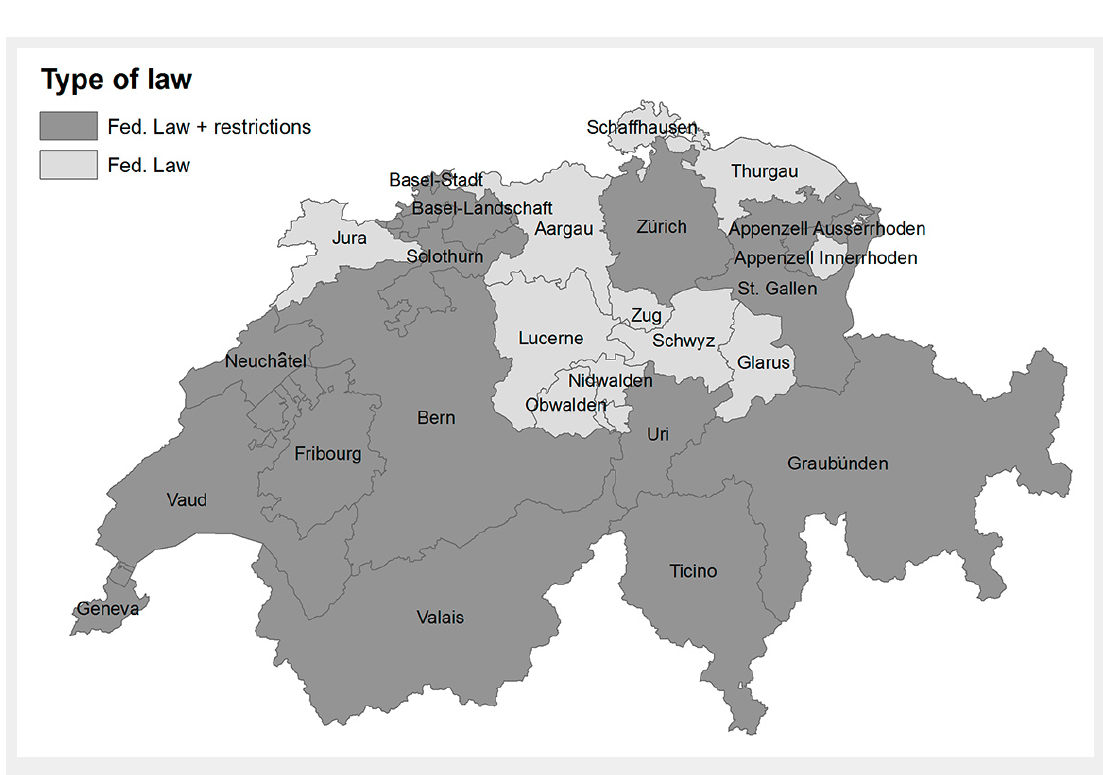
Figure 1 Geographical distribution of the two types of smoking ban implemented in each canton in Switzerland. Fed. Law (light grey): cantons which followed only the Federal Smoking Ban; Fed. Law + restrictions (dark grey): cantons which applied additional restrictions to the Federal Smoking